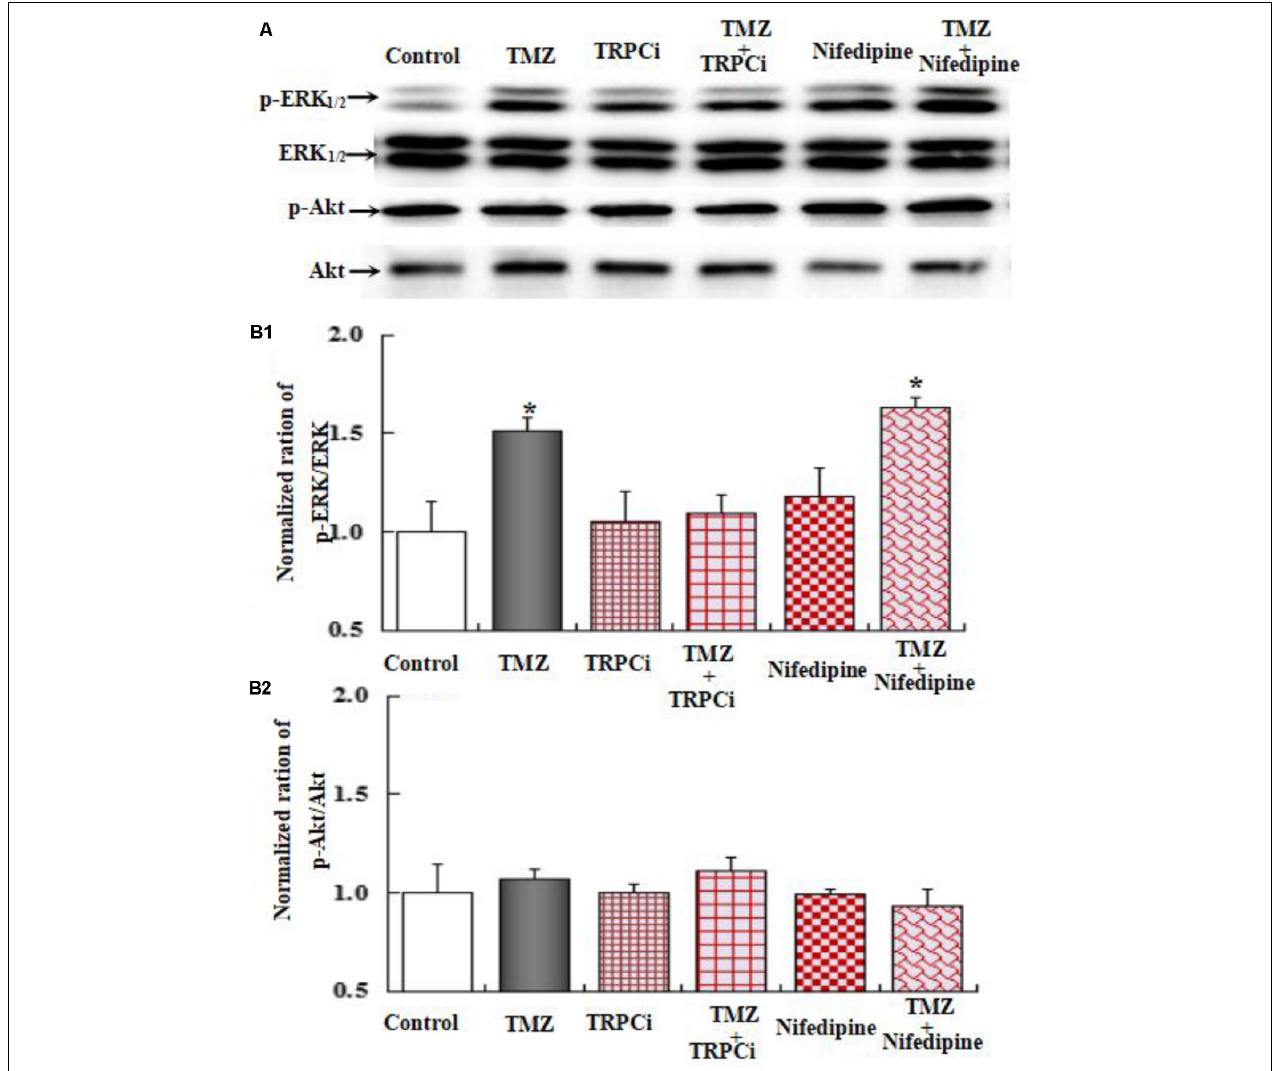
FIGURE 6 | Upregulation of TMZ-induced ERK 1 / 2 phosphorylation by TRPC1 in U251 cells. (A) Cells were incubated for 20 min in the absence of any drug (Control) or in the presence of 5 µ M TMZ. In some experiments, 2 µ g/mL TRPC1 neutralizing antibody (TRPCi) and 1 µ M Nifedipine (Nife) were added 20 min before the addition of TMZ. (B1) Mean ERK phosphorylation was quantified as ratios between p-ERK 1 / 2 and ERK 1 / 2 . (B2) Mean Akt phosphorylation was quantified as ratios between p-Akt and Akt. Similar results were obtained from three independent experiments. SEM values are indicated by vertical bars. ∗ Indicates a statistically significant ( P < 0.05) difference from the negative control